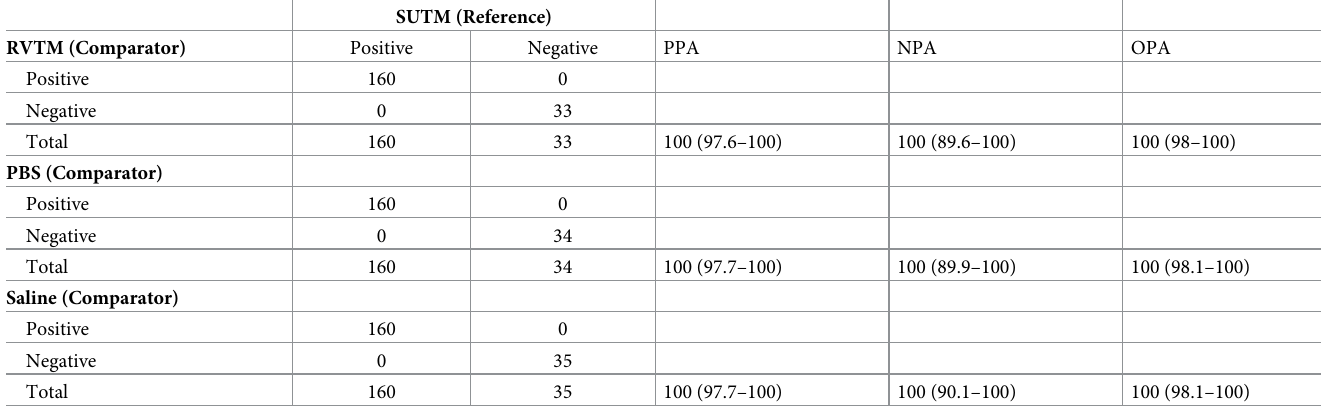
S1 Table. SARS-CoV-2 cultured virus dilution series and corresponding Ct values. Virus dilution 3 was used for high concentration while virus dilution 6 for low concentration.